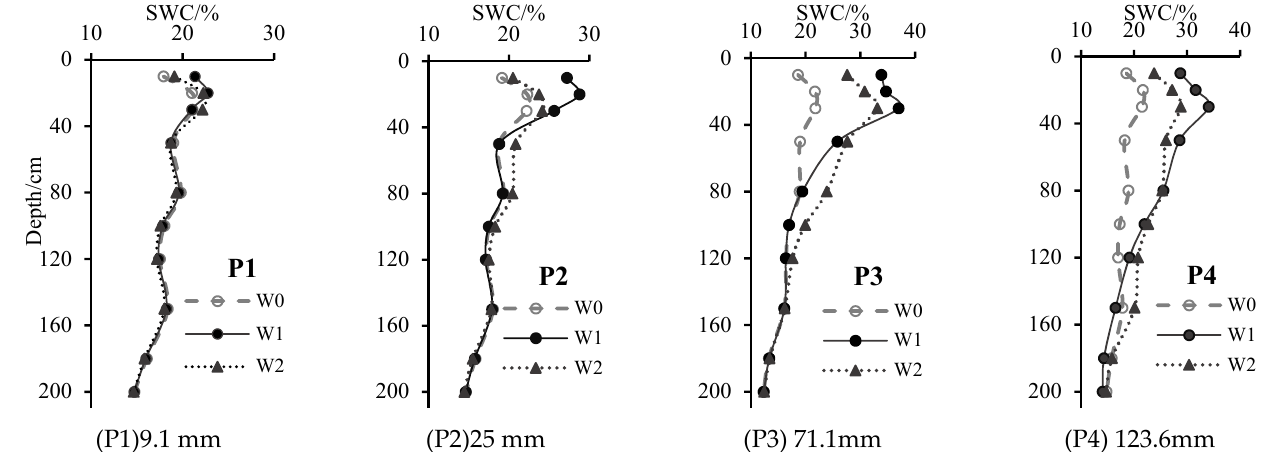
Figure 7. Variations in the soil water contents in the soil profiles before and after rainfall. W0, W1, and W2 are the soil water content before the rainfall, immediately after the rainfall, and 24 h after the end of the rainfall, respectively. SWC is the soil water content.